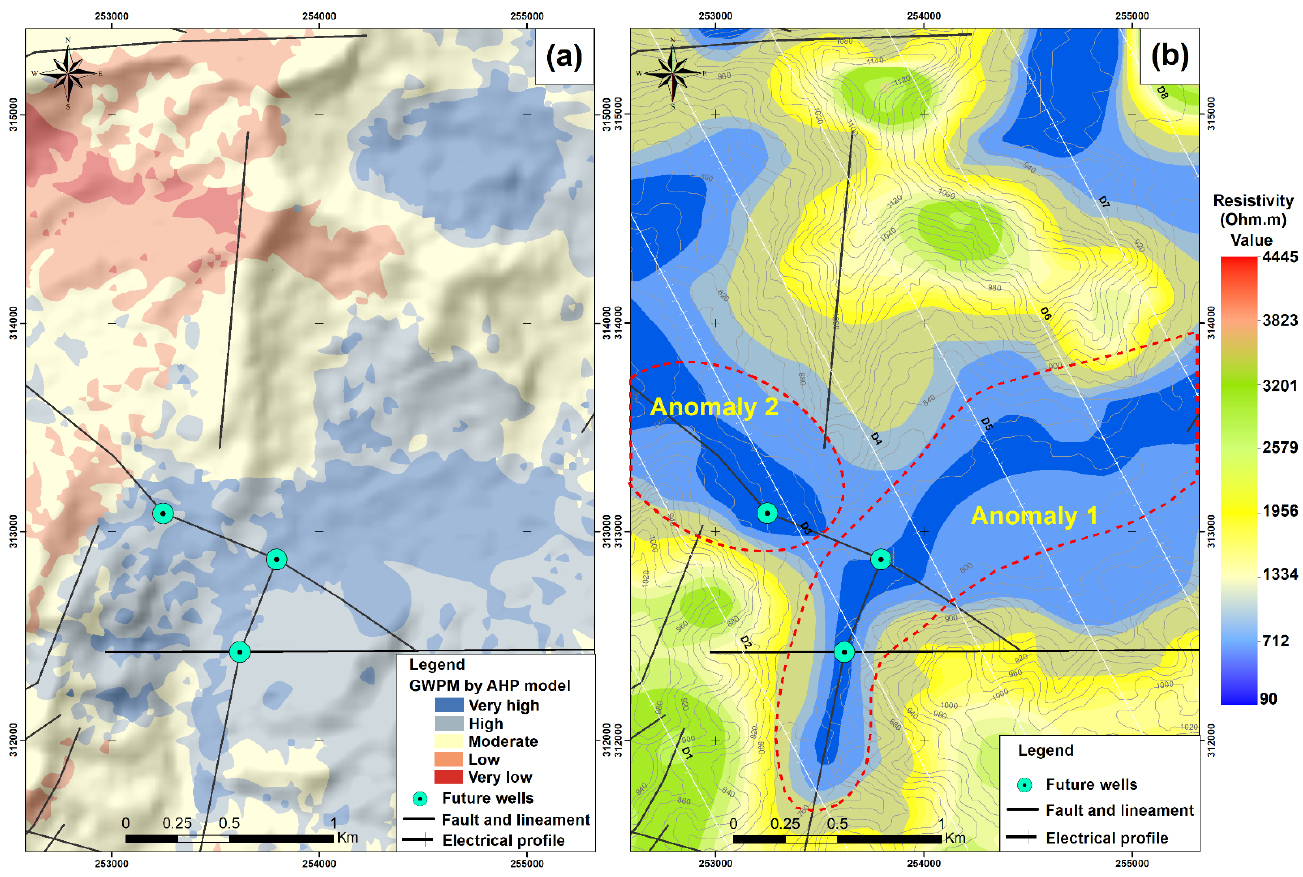
Figure 10. ( a ) Groundwater potential map in area B and ( b ) variation map of the apparent resistivities in Ohm.m in area B deduced from the electrical traces for a length AB = 300 m.